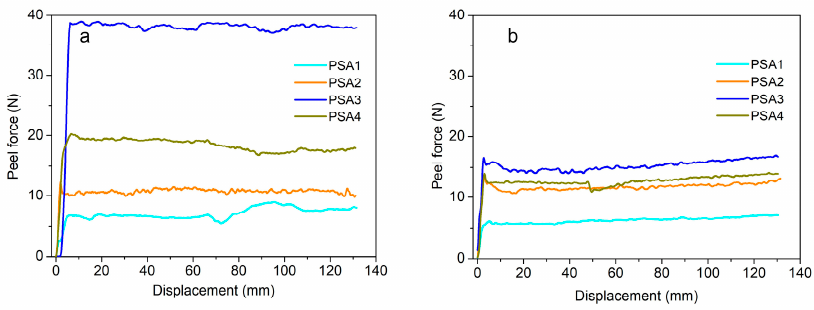
Figure 5. The peel force of WPU-PSAs at 25 ◦ C ( a ) and 60 ◦ C ( b ). The residual glue amount of the bonding constructions after 180 ◦ peel test was also a key indicator to evaluate the performance of WPU-PSAs. The condition of the residual glue amount of four WPU-PSAs at 25 and 60 ◦ C was shown in Figure 6. PSA2, PSA3 and PSA4 had less residual glue than PSA1 at 25 ◦ C. Obviously, residues of all WPU-PSAs at 60 ◦ C increased to varying degrees than at 25 ◦ C. The amount of residual glue of PSA2 increased with the increase of temperature, but its degree of increase was much less than that of the other three. Residues of PSA1 were the most obvious both at 25 and 60 ◦ C. Since 60 ◦ C was higher than the flow points, residues of both PSA3 and PSA4 also increased significantly from 25 to 60 ◦ C. This revealed that the residual glue of WPU-PSAs could be controlled by adjusting the crosslinking degree and the interaction forces between macromolecules. If there is little or no residual glue, we have the possibility to reuse PSA. The problems of heat resistance and adhesive residue might be solved by improving the predesigned working temperature of